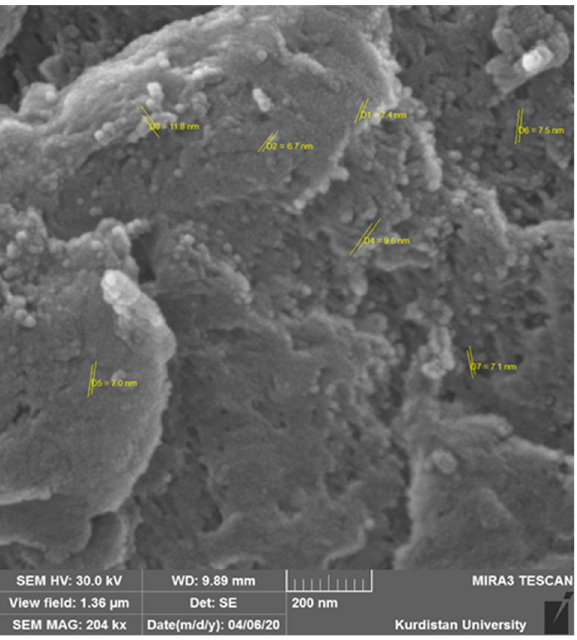
Figure 1. Representative field-emission scanning electron microscope image of chitosan nanoparticles.